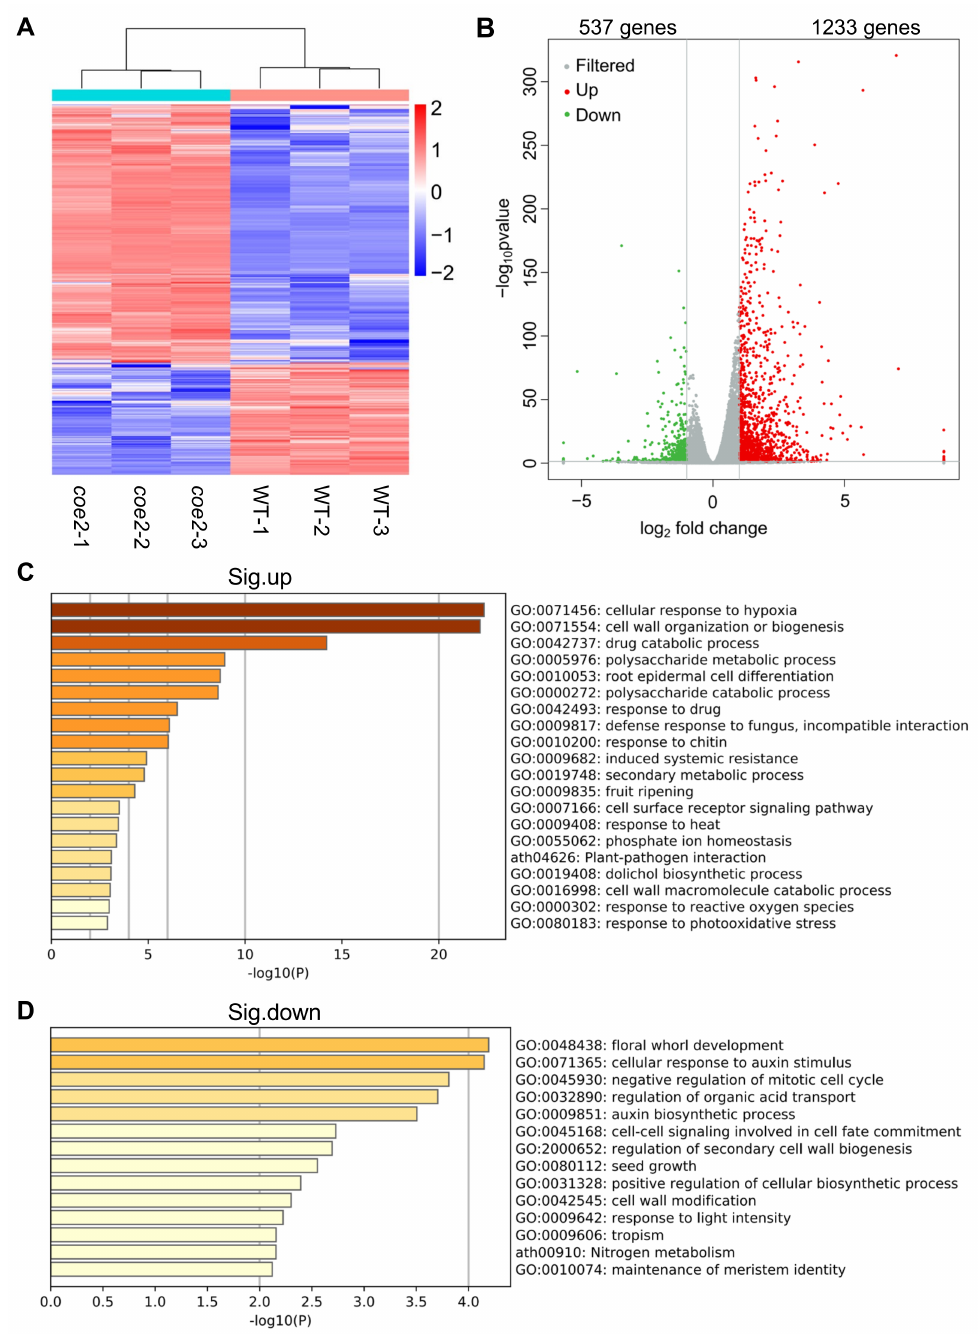
Figure 5. Analysis of the differentially expressed genes (DEGs) in roots of coe2 and WT. ( A ) Heatmap displays the expression pattern of the DEGs in roots of coe2 and WT. ( B ) Volcano plot shows the distribution of the DEGs in cotyledons of coe2 and WT. Gene Ontology (GO) analysis of the up- regulated DEGs ( C ) and significantly down-regulated DEGs ( D ) in roots of coe2 compared with